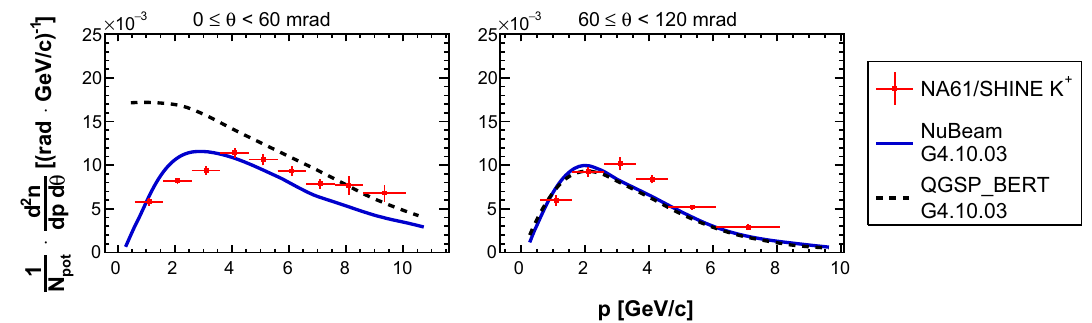
QGSP_BERT (dashed black line) physics lists from Geant4.10 .03 [27,28] are overlaid on top of the data